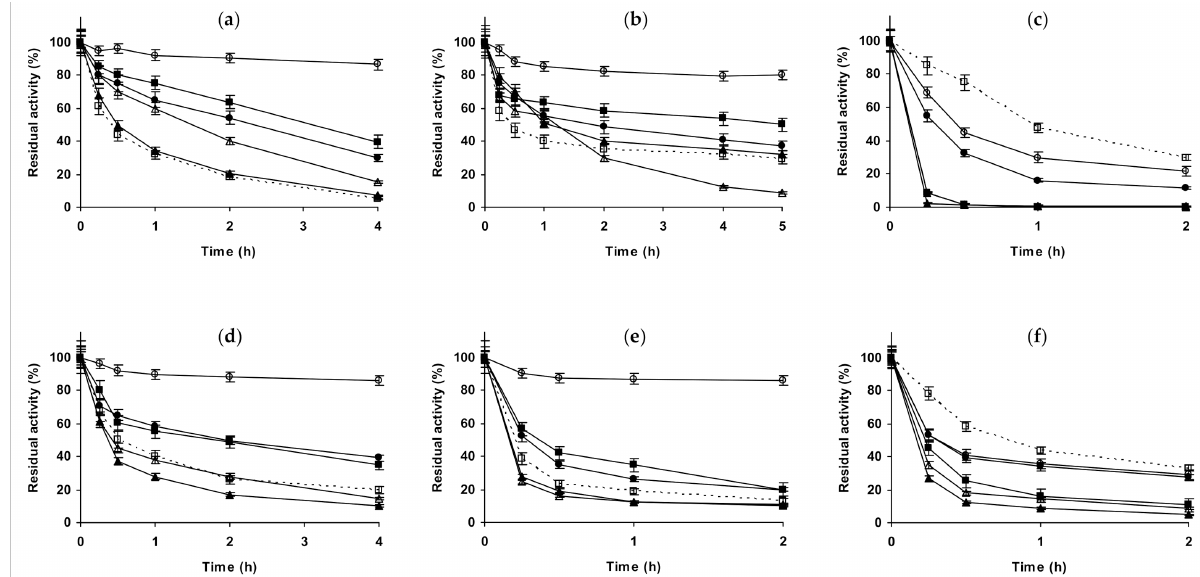
Figure 1. Effect of ionic strength and inactivation pH on the stability of different immobilized preparations of CALA. Octyl-CALA: ( a ) pH 5.0 and 87 ◦ C; ( b ) pH 7.0 and 82 ◦ C; ( c ) pH 9.0 and 55 ◦ C. Glutaraldehyde-CALA: ( d ) pH 5.0 and 83 ◦ C; ( e ) pH 7.0 and 87 ◦ C; ( f ) pH 9.0 and 43 ◦ C. Other specifications are described in the Methods section. Dotted line, empty squares: references; full triangles: 1 M NaCl; empty triangles: 3 M NaCl; full circles: 1 M (NH 4 ) 2 SO 4 ; empty circles: 3 M (NH 4 ) 2 SO 4 and full squares: 1 M Na 2 SO 4